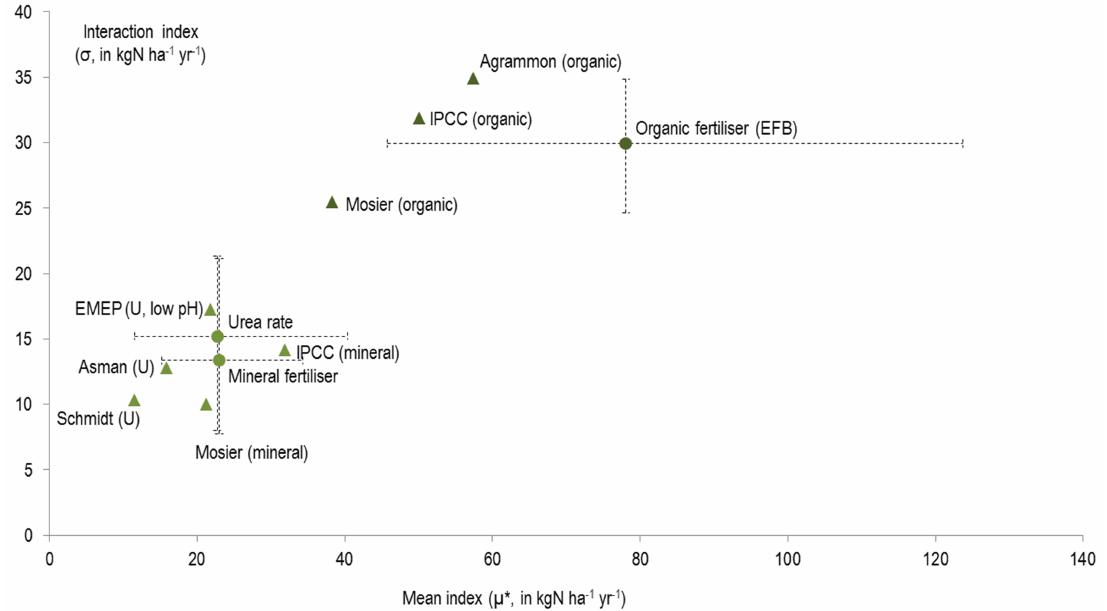
Figure 10. Morris’s sensitivity indices for sub-models calculating NH 3 volatilisation. The input variables related to organic inputs (dark green) had higher Morris indices than mineral inputs (clear green). Sub-models tested: IPCC-2006, Mosier, Asman, Schmidt, Agrammon, EMEP-2009 and EMEP-2013. Indices lower than 10kg Nha − 1 yr − 1 are not represented. Triangles: emission factors; circles: N inputs. AS: ammonium sulfate; U: urea; EFB: empty fruit bunches, i.e. organic